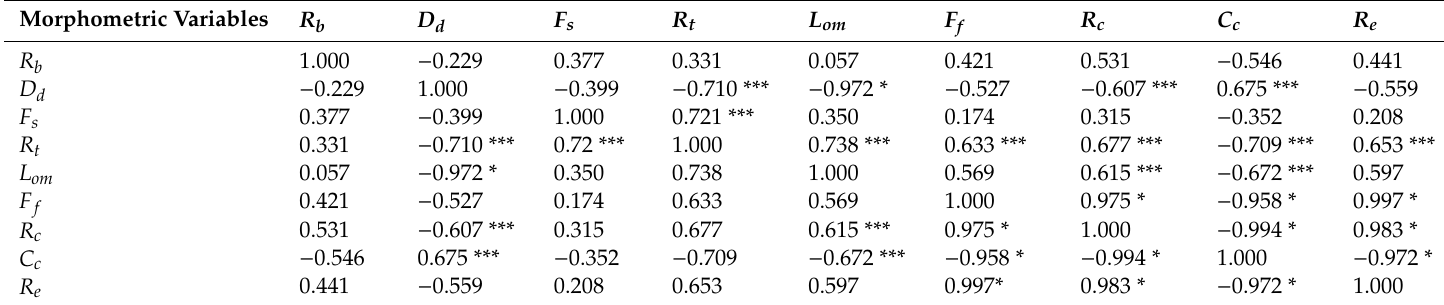
Table 7. Correlation matrix between linear, areal, and shape morphometric variables of nine sub-watersheds of BW.